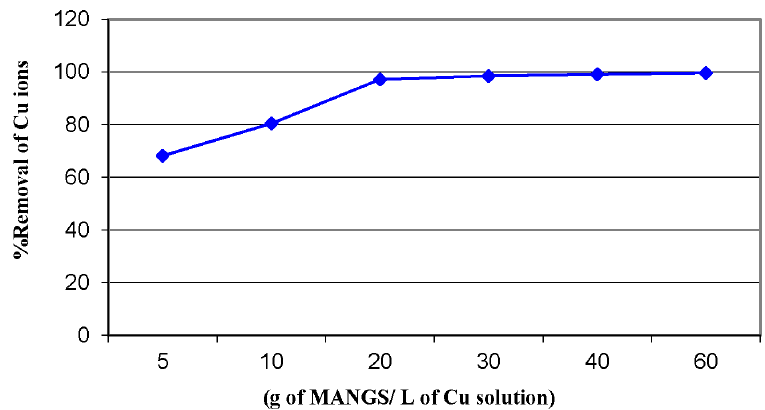
Figure 10. Effect of the MANSG dose on the copper sorption process (solution concentration of ion = 1000 ppm; time = 90 min; agitation speed = 200 rpm; solution volume = 25 mL; pH = 7).